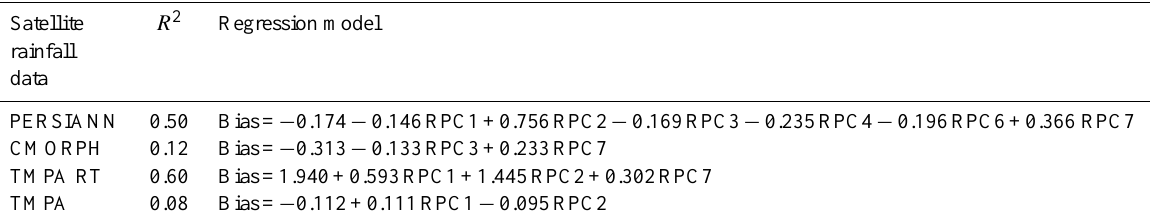
Table 6. Regression model results of each satellite rainfall data set. Note that the model was developed based on data from all 166 stations. All variables in the model are independent and statistically significant at level